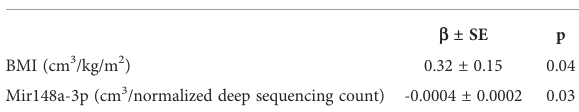
TABLE 3 Multivariable factors associated with marrow adiposity at the distal femoral diaphysis among acute and chronic SCI, n=30.